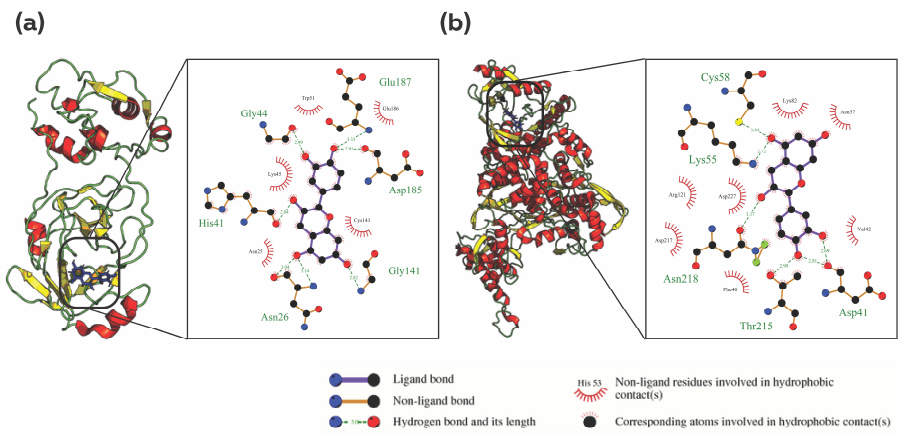
Figure 1. Analysis of protein–ligand interaction for Methyl rosmarinate (PubChem CID: 6479915) against Mpro and PLpro; Analysis of the binding pocket and types of interaction between ( a ) 6479915 and Mpro, ( b ) 6479915 and Plpro. The figure illustrates the 3D and 2D binding modes of Methyl rosmarinate with the key amino acid residues of the Mpro and Plpro.